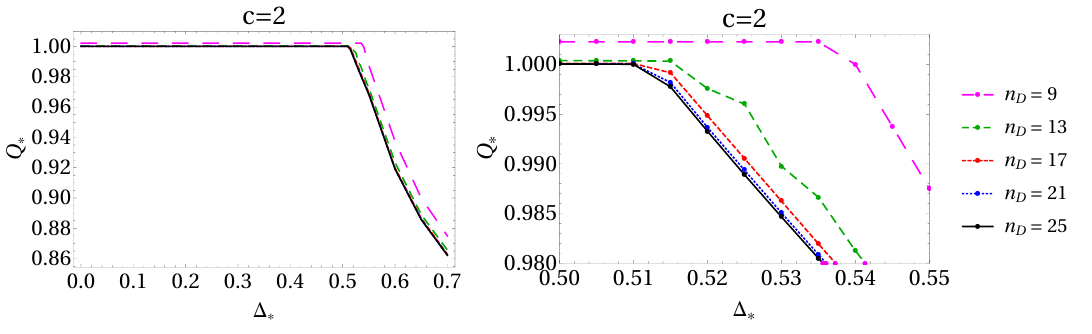
Figure 5 . Bound on the charge gap Q (cid:3) and the scalar dimension gap (cid:1) (cid:3) at c = 2. The region near the kink in the left plot is magni(cid:12)ed and shown in the right